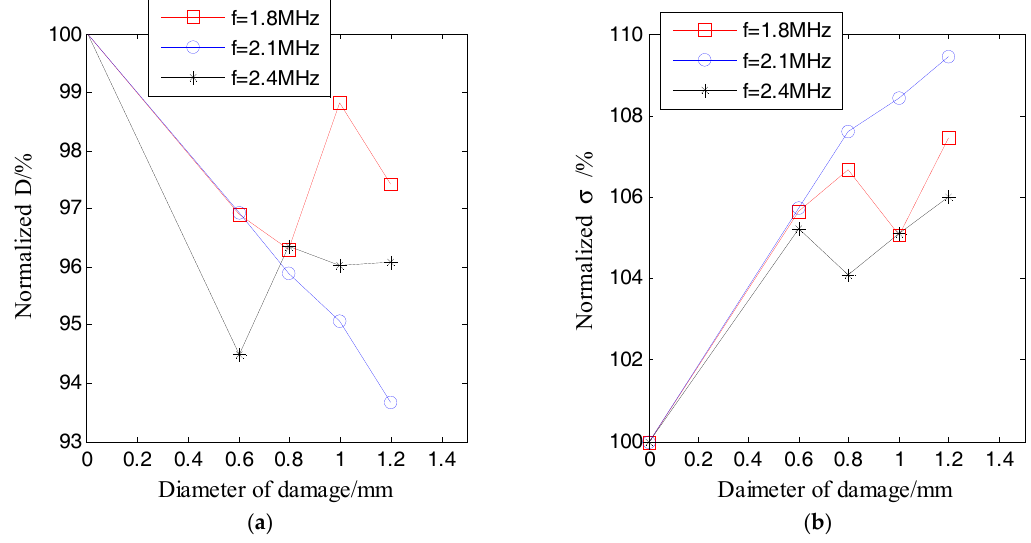
Figure 12. Normalized ultrasonic energy coefficients of damage D1 versus the damage size under different excitation pulses: ( a ) ultrasound energy diffusion coefficient; ( b ) ultrasonic energy dissipation coefficient.